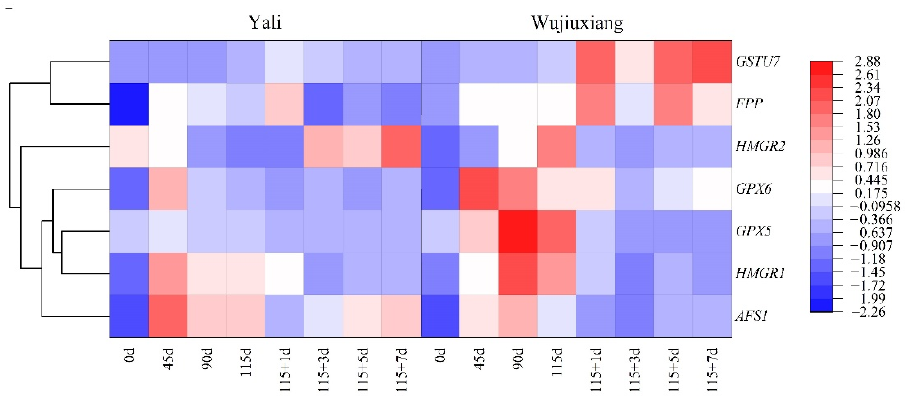
Figure 3. Expression profiles of α -farnesene and CTols biosynthesis-related genes of the ‘Yali’ and ‘Wujiuxiang’ pears during cold storage and the shelf life period. Note: 115 + 1, 115 + 3, 115 + 5, and 115 + 7 indicate 1, 3, 5 and 7 days of shelf life at room temperature (20 ◦ C) after cold storage at 0 ◦ C for 115 days. Red and high positive values indicate high gene expression, while blue and low negative values indicate low gene